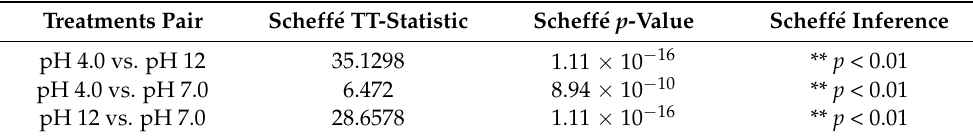
Table 5. Analysis of variance using the Scheff é method based on temperature